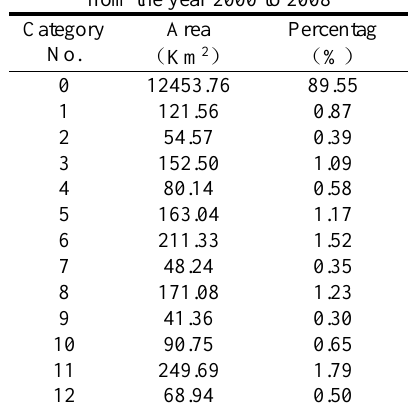
Table 5 Statistics of change detection results of MCVA method